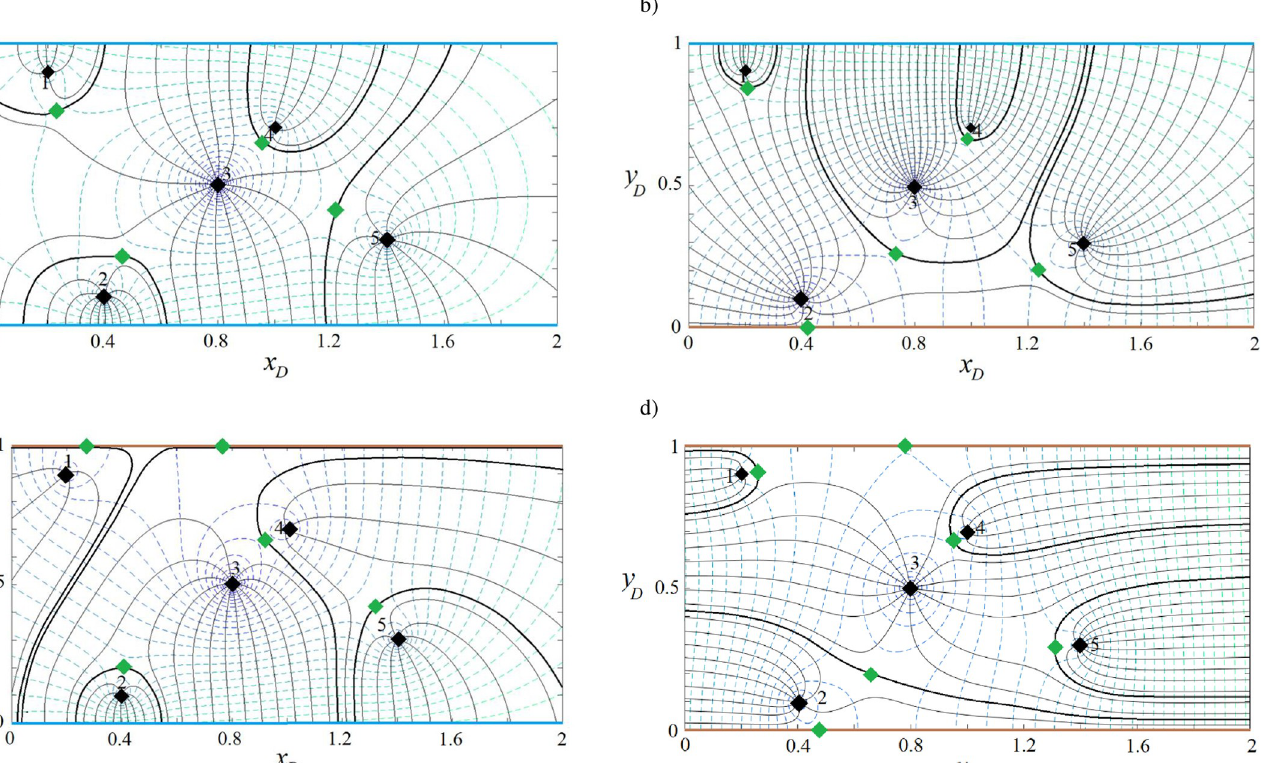
PLOS ONE | https://doi.org/10.1371/journal.pone.0229767 March 5,